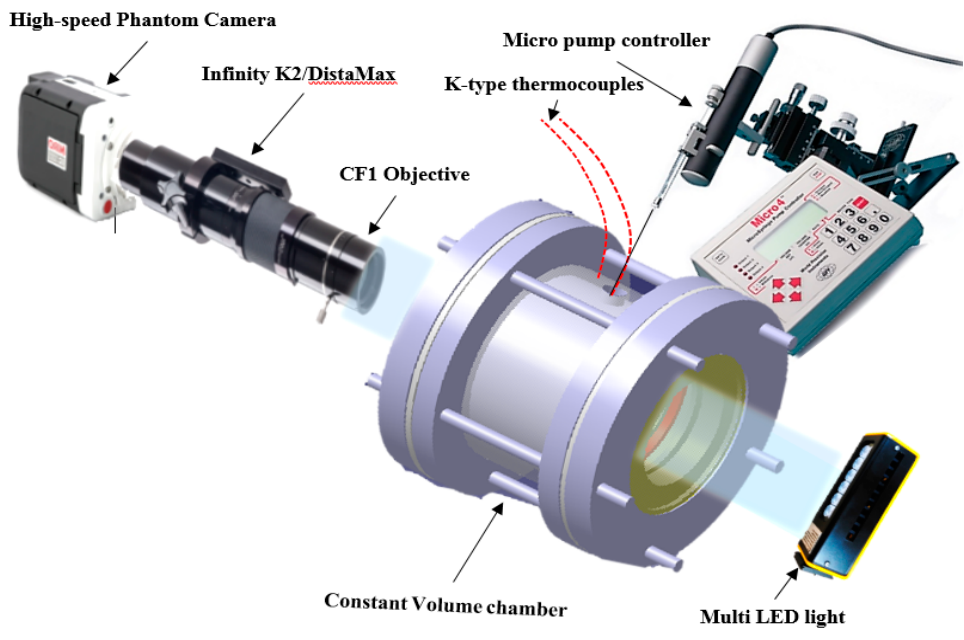
Figure 2. Schematic of the combustion chamber showing the optical accesses and the long-distance microscope imaging system. The Multi LED light used to provide the back illumination.